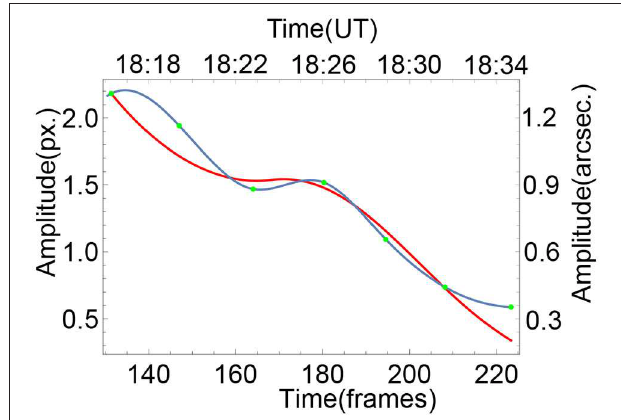
FIGURE 7 | The dependence of the amplitude of the coronal loop oscillation on time. Green points correspond to maxima of the peaks plotted in Figure 6 , the blue line is the fitted observed amplitude-time profile, and the red line represents the theoretical amplitude-time profile with ζ κ 2.4, and α = =